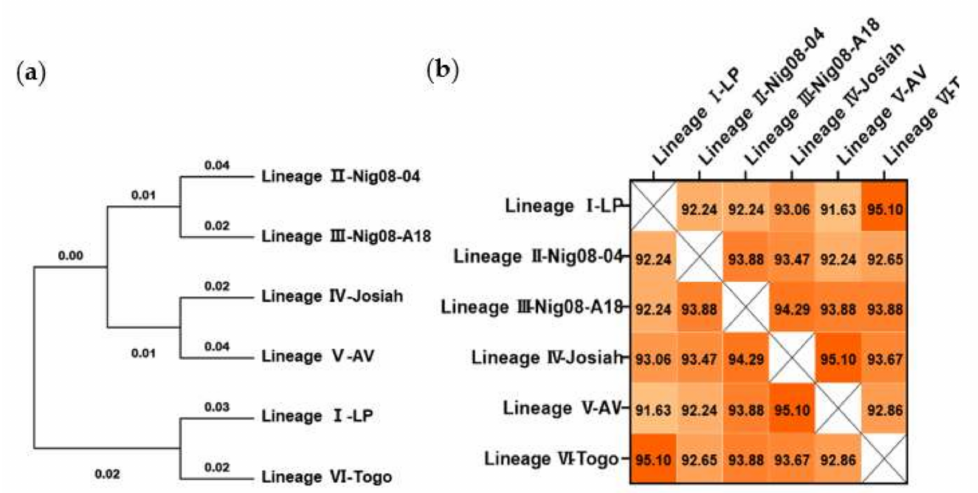
Figure 1. Phylogenetic and conservation analyses of Lassa virus (LASV) glycoprotein precursor (GPC) amino acid sequence. ( a ) Phylogenetic trees were inferred using the maximum likelihood method and Jones–Taylor–Thornton (JTT) matrix-based model. ( b ) Sequences were aligned by MUSCLE analysis, and the matrix for pairwise score similarity was converted into a heatmap. The GenBank accession IDs used for alignments are as follows: AAF86701.1 (LP), ADU56610.1 (Nig08-04), ADU56614.1 (Nig08-A18), ADY11068.1 (Josiah), CCA30314.1 (AV), and AMR44577.1